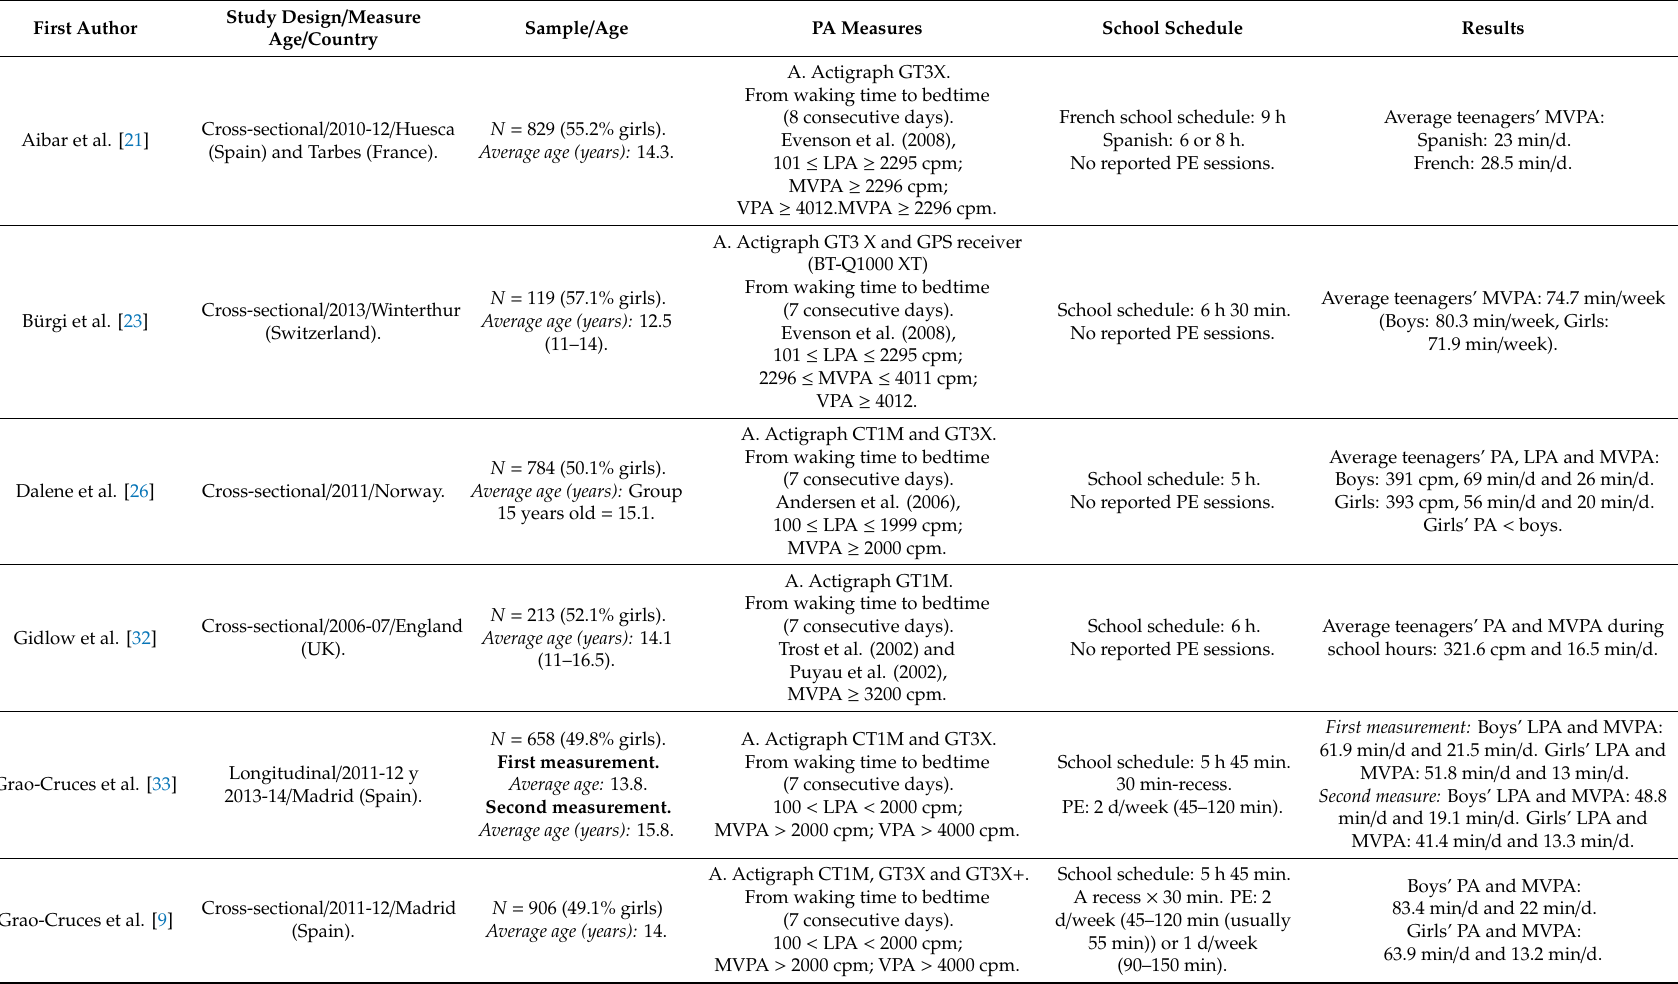
Table 4. Characteristics of the analyzed studies with participants of secondary